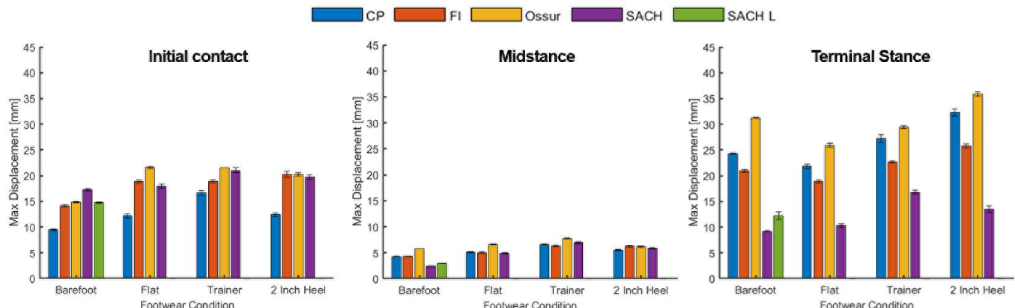
Fig 4. Maximum displacement of each prosthesis-footwear combination at initial contact, midstance, and terminal stance loading. CP = College Park; FI = Freedom Innovations; SACH L = barefoot condition with L-block. Error bars denote 95% confidence interval.